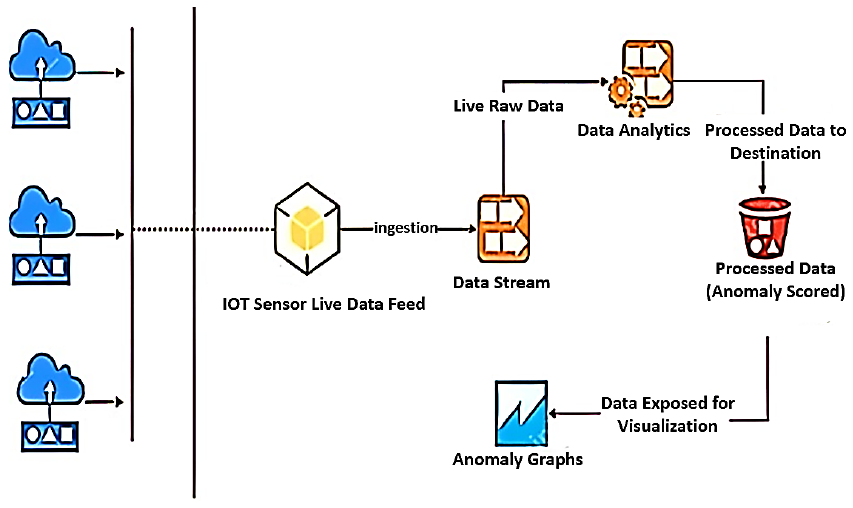
Figure 2. Architecture Used for Anomaly Detection and Performance Testing [13].